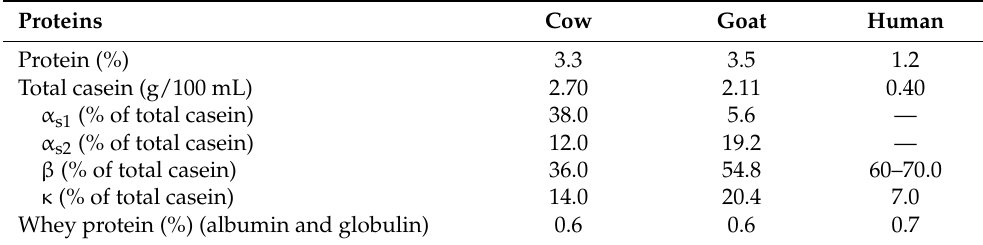
Table 1. Comparison of protein composition among cow, goat and human milks.